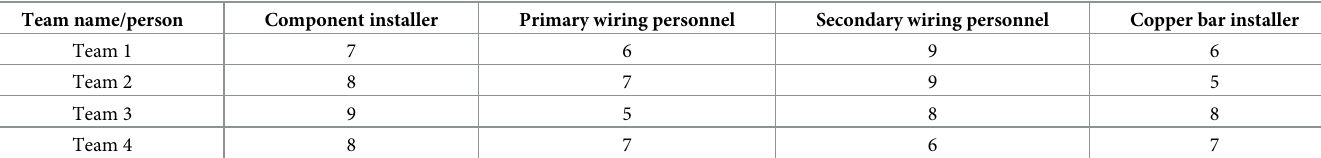
Table 3. Distribution of team